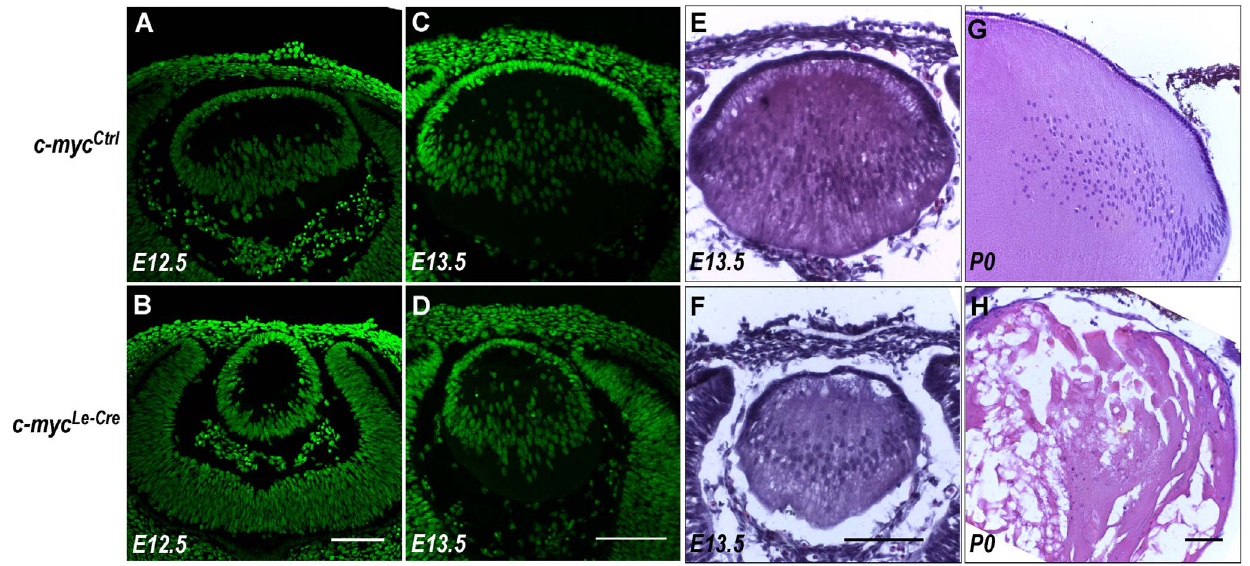
Figure 2. Defects in lens embryonic development of c-myc-deficient lens. (A–D) Representative confocal pictures of E12.5 ( A–B ) and E13.5 ( C–D ) control ( c-myc Ctrl ) and c-myc-deficient ( c-myc Le-Cre ) lens cryosections stained with sytox green. The pattern of nuclear staining of c-myc– deficient and control lens indicates a developmental delay. ( E–H ) Representative pictures of E13.5 sections of c-myc Le-Cre and c-myc Ctrl lens stained with hematoxilin and eosin ( E–F ) and P0 ( G–H ). At P0, the morphology of c-myc-null lens is severely compromised. Scale bar: 100 m